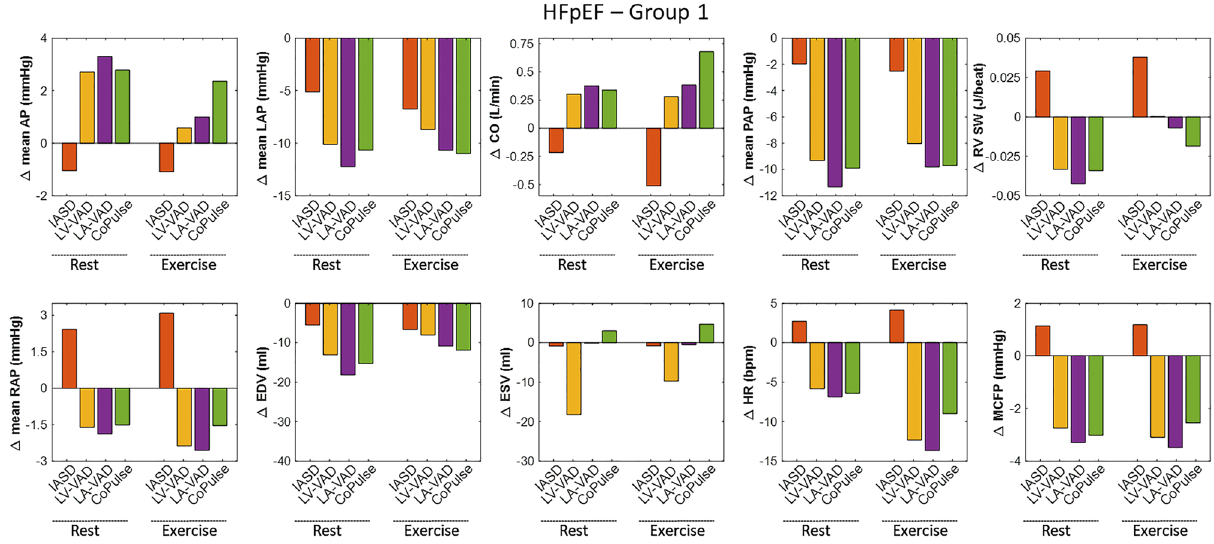
Figure 3. Hemodynamic effect of the four device-based treatment options in relation to baseline values of Group 1.